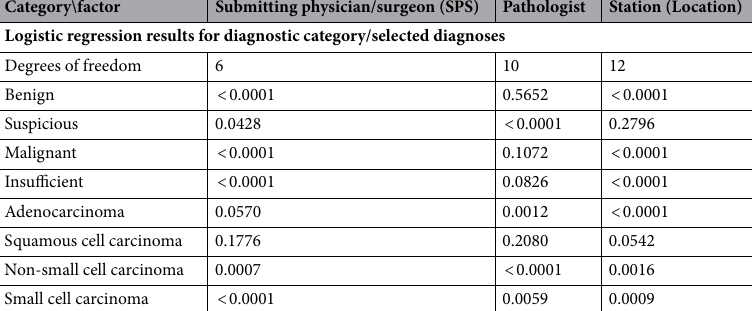
Category\factor Submitting physician/surgeon (SPS) Pathologist Station (Location) Logistic regression results for diagnostic category/selected